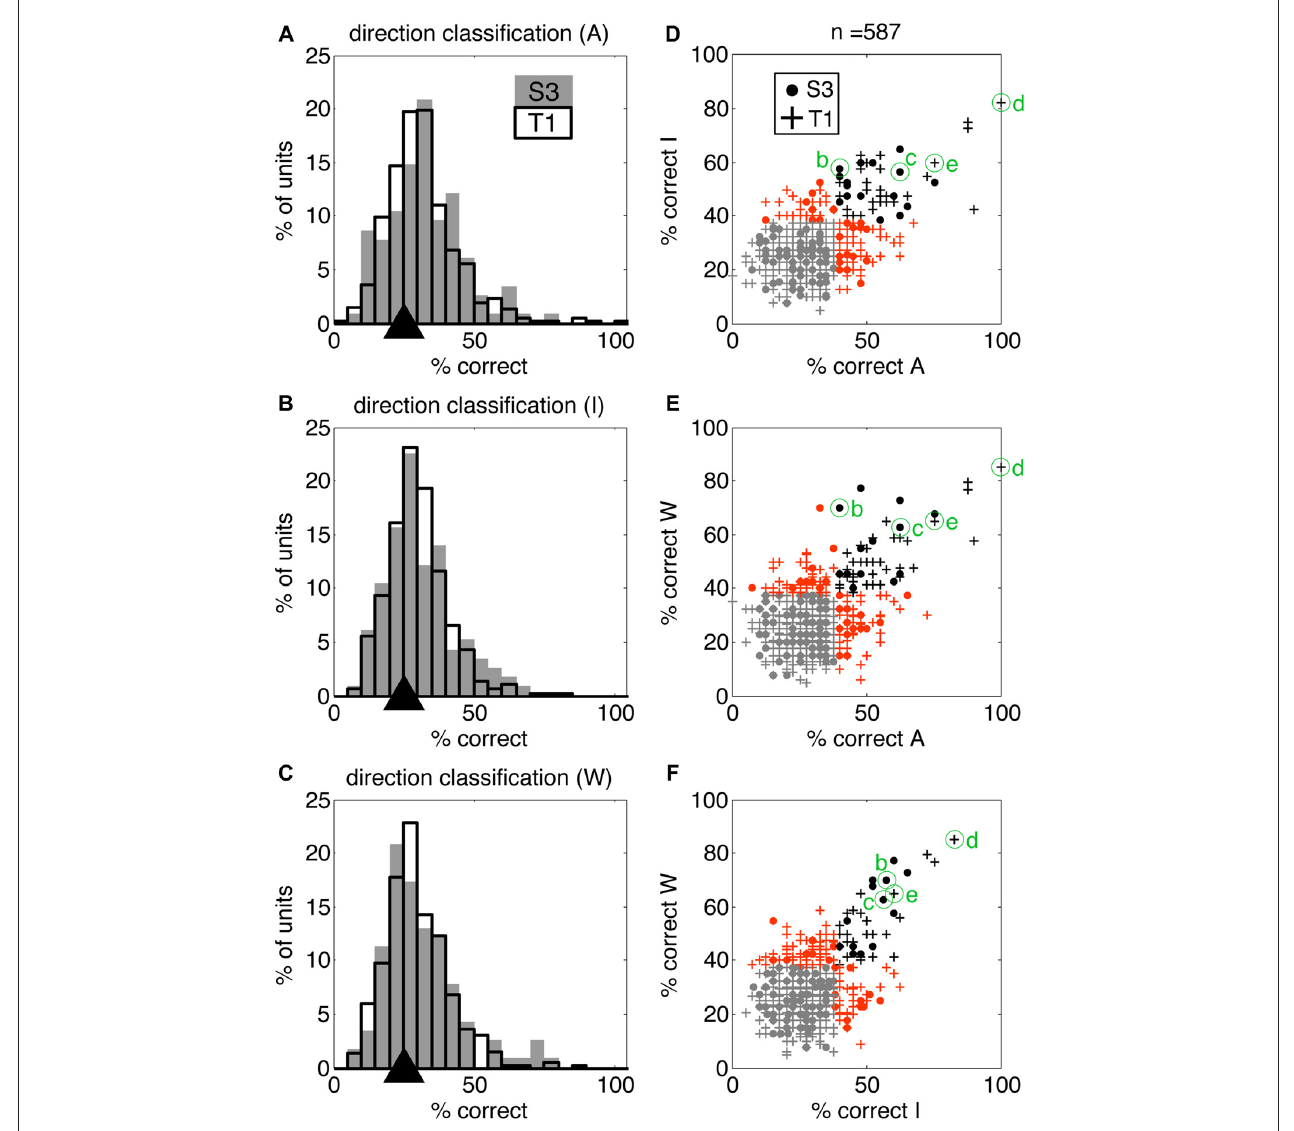
FIGURE 3 | Single units display action-related information across volitional states. SSIMS NN classifiers were used to decode actions (reaching movements to four different targets) using single-unit data. (A–C) Distribution of single-unit classification results across neurons for each VoS, pooled across sessions for each participant. Gray bars correspond to participant S3, black outlines to participant T1. Black triangles on the x -axis mark the expected chance value. (D–F) Scatter plots comparing decoding performance across pairs of conditions. In each plot, units yielding classification below the 95% confidence limit of the chance distribution are shown in gray, units over the 95% confidence limit in only one category shown in orange, and units yielding significant decoding in two categories are shown in black. Filled circles correspond to units from participant S3, while + signs are used for units from participant T1. The units labeled (B–E) correspond to those shown in Figure 1